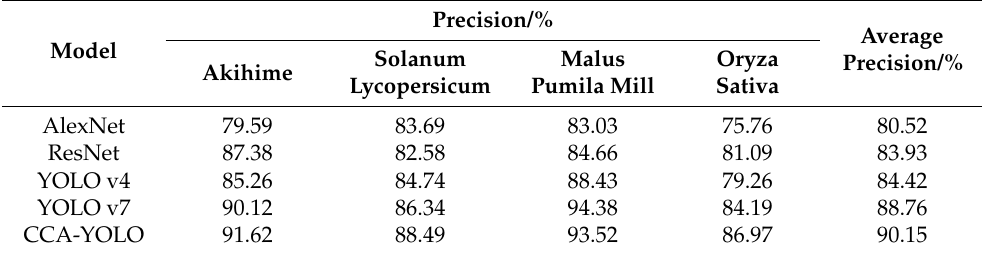
Table 4. Different targets’ detection model